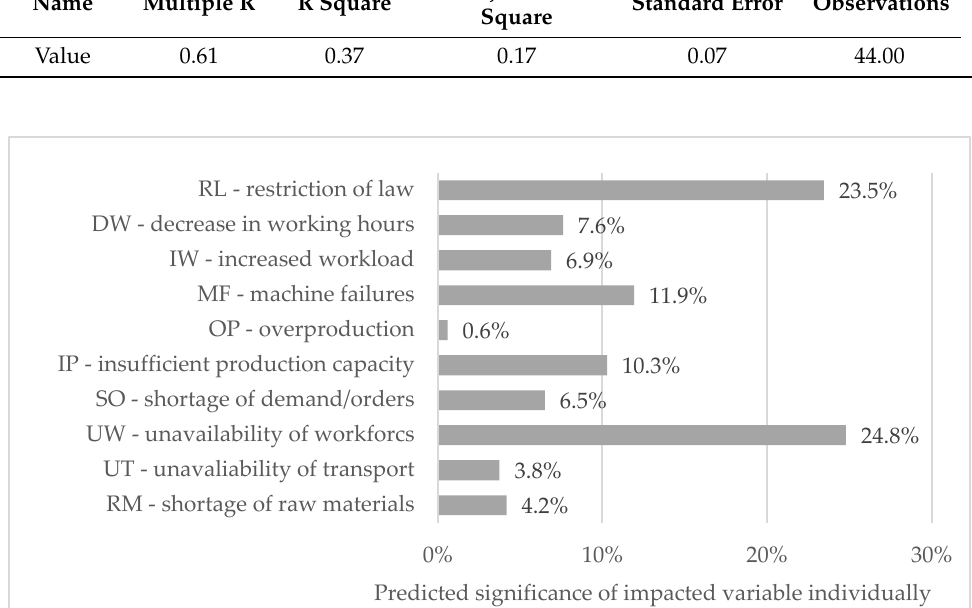
Table 2. Correlations among aspects of operational